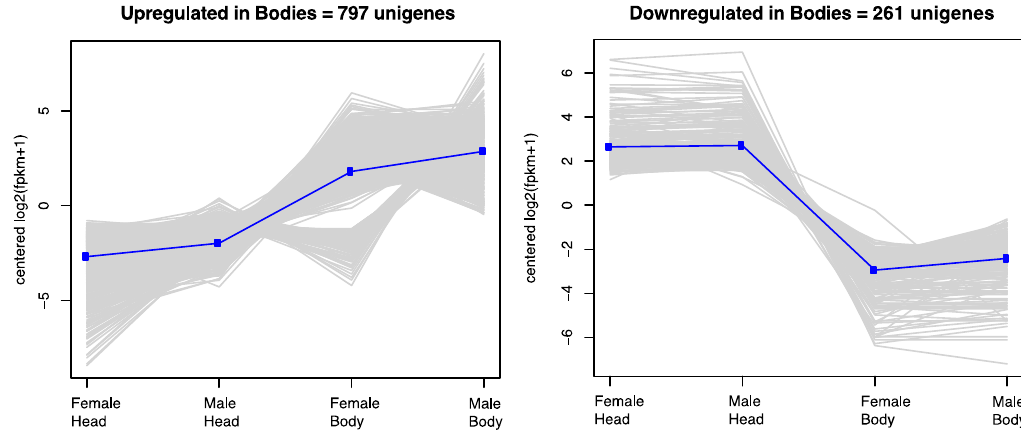
Figure 2. Hierarchical clustering of the di ff erentially expressed genes from the head appendage (Head) and headless body (Body) datasets. Di ff erentially expressed transcripts were partitioned into two clusters representing genes upregulated and downregulated in headless bodies (Supplementary File